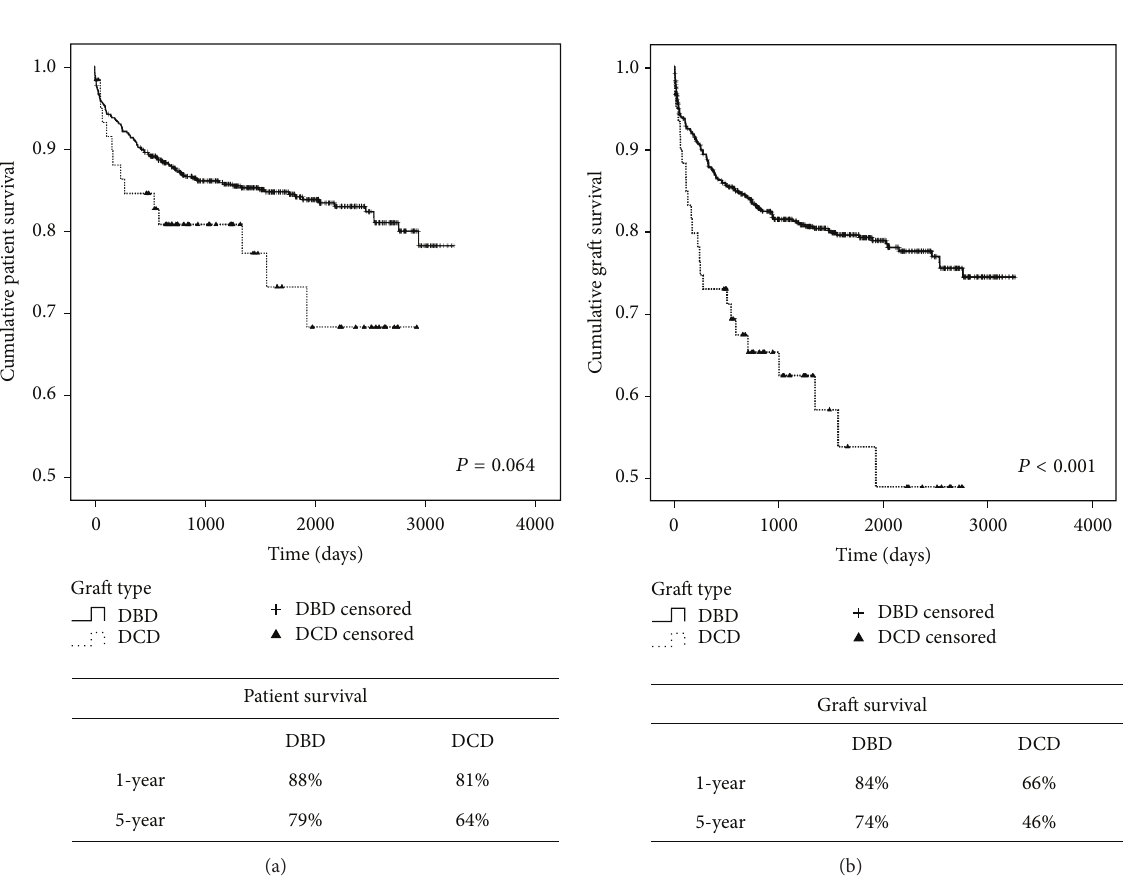
Figure 1: Kaplan-Meier curves of (a) time to death and (b) time to graft failure. DCD: donation after cardiac death and DBD: donation after brain